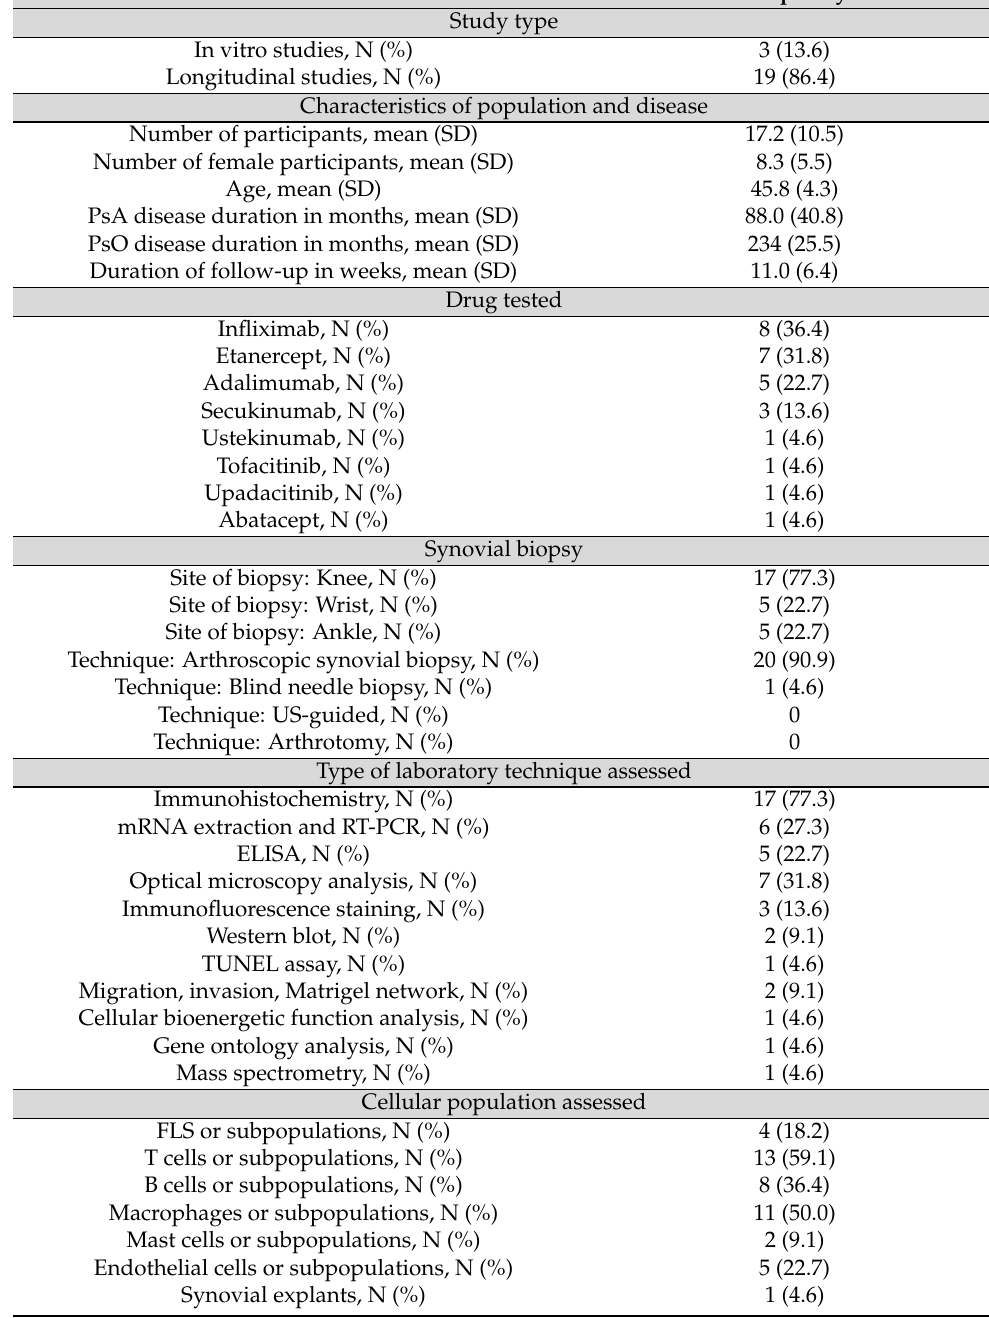
Table 1. Main characteristics of the 22 included